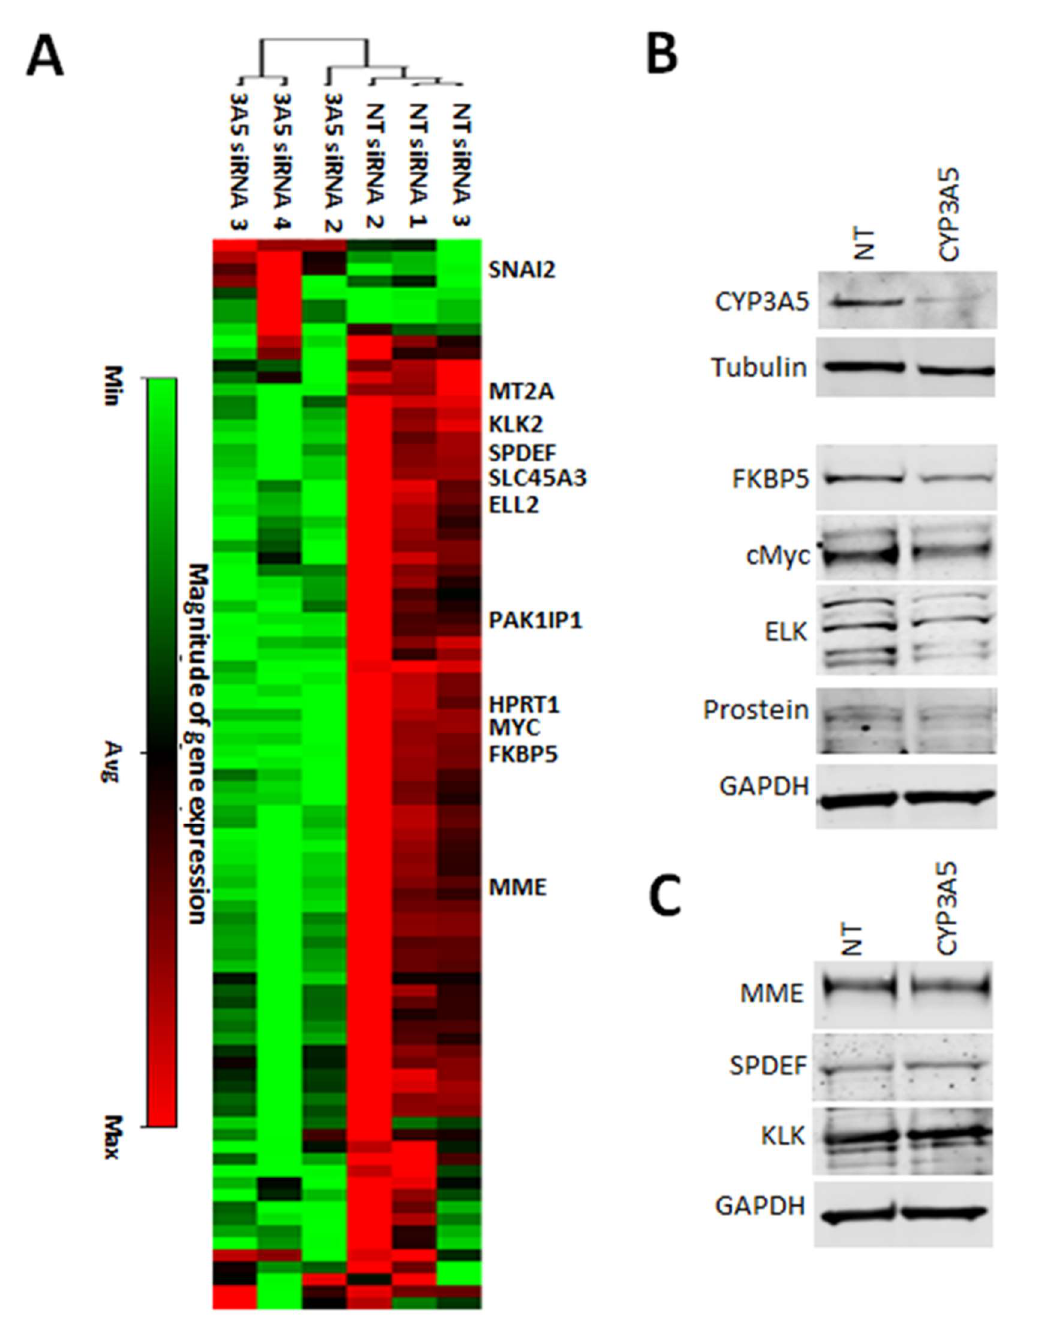
Figure 2. CYP3A5 siRNA downregulates expression of AR downstream regulated genes. ( A ) MDAPCa2b cells were seeded into 6-well plates. After 48 hours of allowing them to settle, the cells were treated with CYP3A5 siRNA or Non-Target siRNA and incubated for another 72 hours. RNA was isolated, followed by cDNA preparation, which was used in RT 2 profiler assay. Fold-change values greater than 1 are indicated as positive- or an up-regulation (red) and less than − 1 are indicated as negative or down-regulation (green). The p values are calculated based on a Student’s t -test of the replicate 2ˆ ( − Delta CT) values for each gene in the control group and treatment groups. ( B , C ) Protein expression of the 7 genes that changes in gene expression was evaluated using western blotting. FKBP5, cMYC, ELK, and Prostein (SLC45A3) showed decreased protein expression in response to CYP3A5 knockdown, whereas, MME, SPDEF, and KLK showed no change.